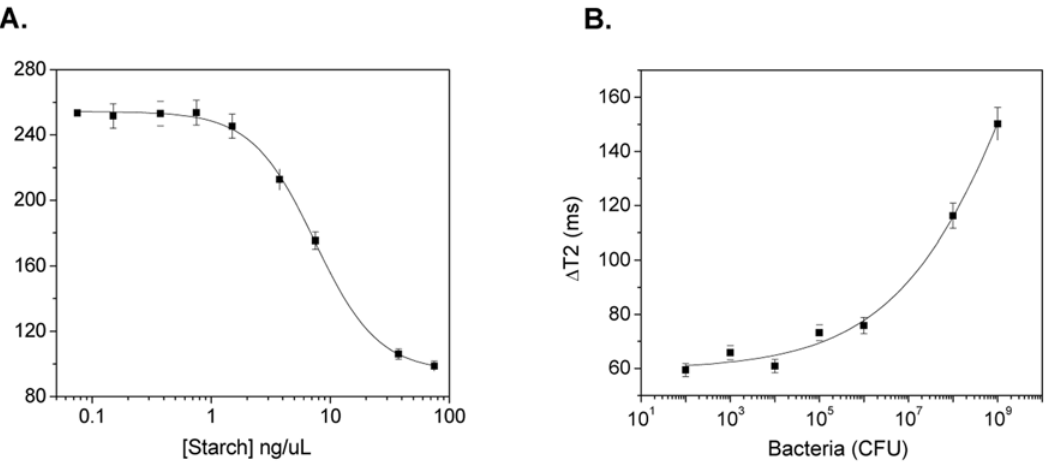
Figure 2. Nanoparticle-mediated sensing of polysaccharide levels and monitoring of bacterial metabolic activity. (A) Quantification of starch in sterile MH broth, and (B) determination of starch consumption due to bacterial metabolism in MH broth, using the dextran-coated polysaccharide nanosensors.